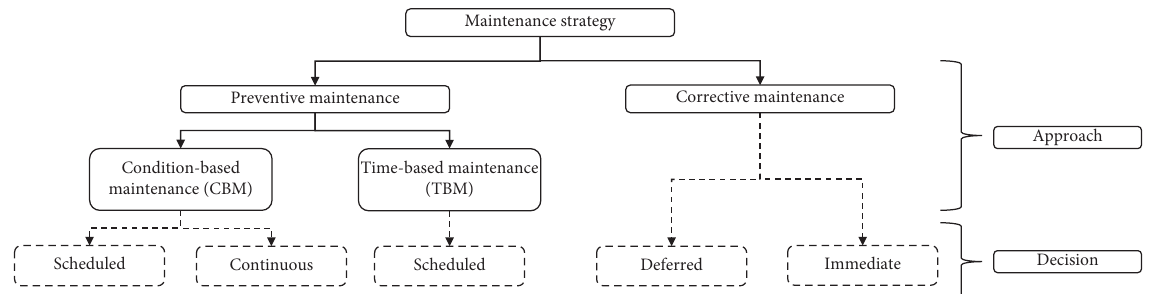
Figure 2: Common concepts and procedures in reliability maintenance.